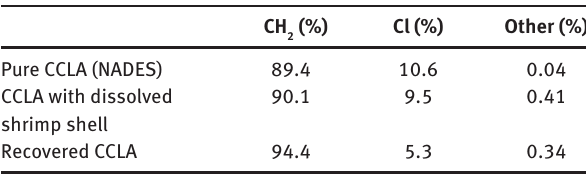
Table 4: Composition of the NADES CCLA before and after shrimp dissolution, chitin isolation and NADES recycle.